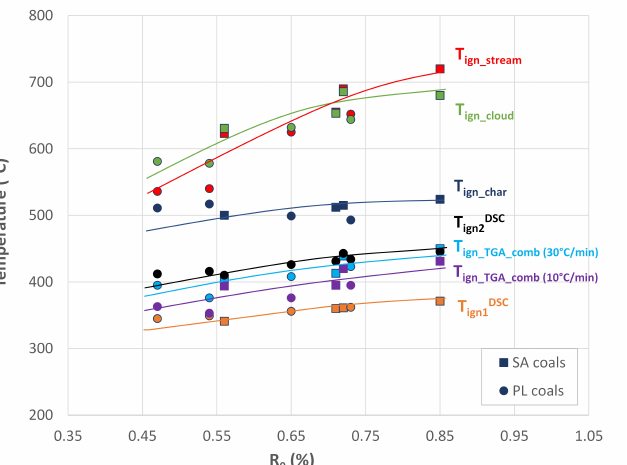
Figure 10. Comparison of ignition temperatures determined with TGA/DSC, T TGA (10 ◦ C/min), T DSC , cloud, T cloud , and T stream measurements at various vitrinite reflectance values ign ign ign ( R 0 ) of